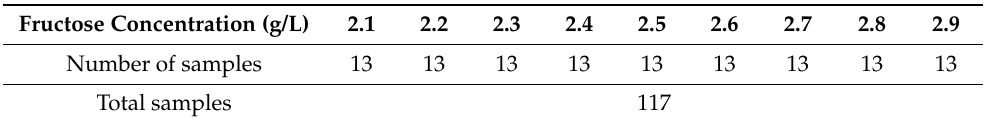
Table 2. Number of samples and their composition used in the experiment. A total of 117 samples of distilled water with different concentrations of fructose, in the range of 2.1 g/L to 2.9 g/L, were analyzed.